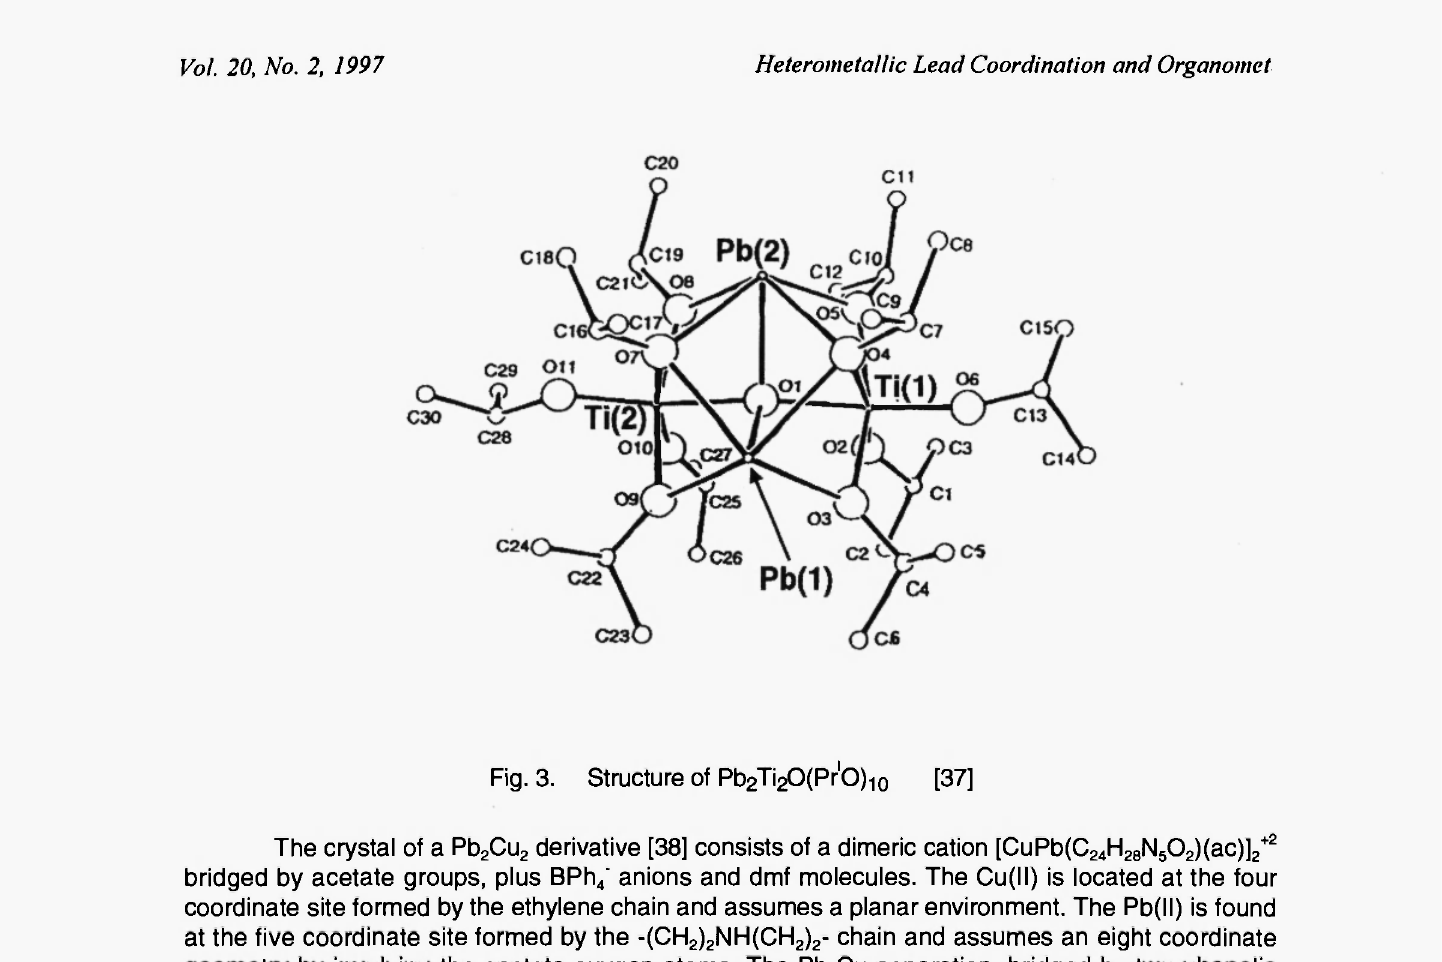
Fig. 3. Structure of Pb